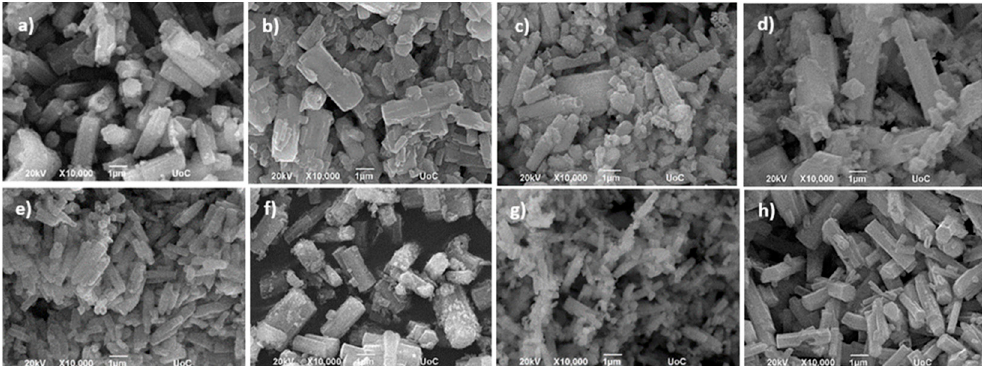
Figure 5. SEM images of ( a , e ) referred to MgTiO 3 , ( b , f ) to CoTiO 3 , ( c , g ) to NiTiO 3 , and ( d , h ) to ZnTiO 3 before and after annealing process, respectively. So top row images are referred to materials before annealing and bottom row images are referred to materials after annealing in an order of MgTiO 3 , CoTiO 3 , NiTiO 3 and ZnTiO 3 .